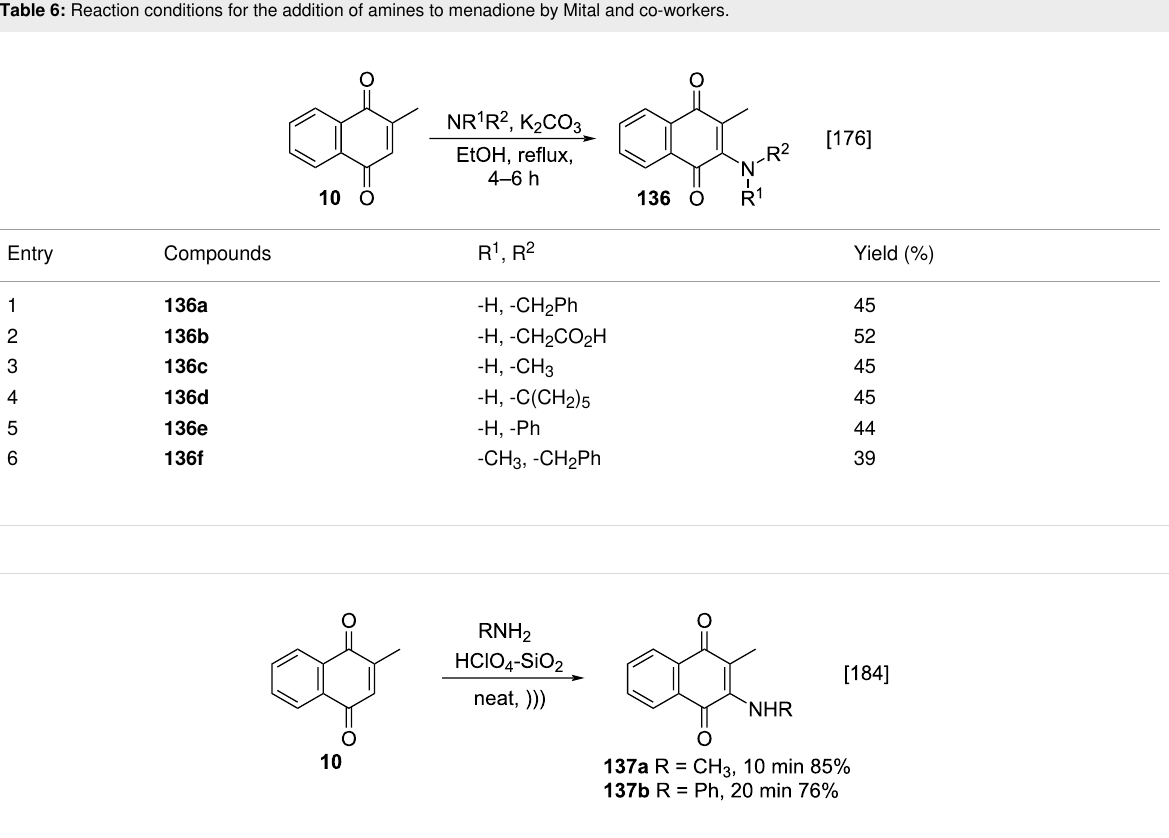
Scheme 46: Addition of different natural α -amino acids to menadione.